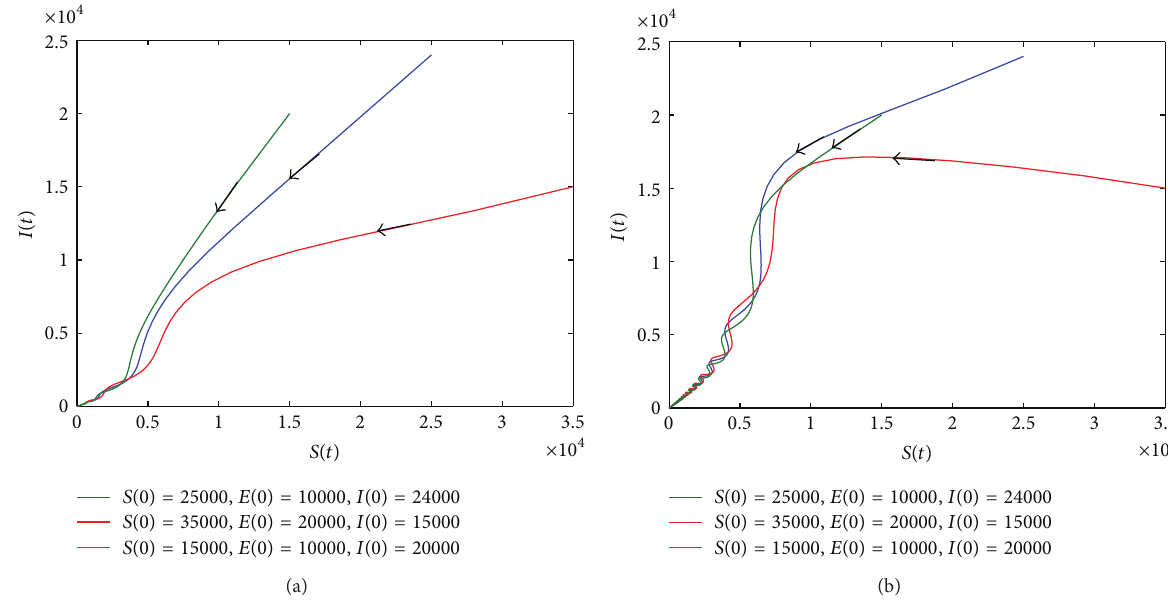
Figure 4: Phase plane of 𝑆(𝑡) and 𝐼(𝑡) . (a) When the parameter values are 𝑟 = 0.11 , 𝑎 = 0.9 , 𝑏 = 0.2 and 𝜇 = 0.3 , 𝑅 0 = 1.4991 , 𝑅 𝑑 = 1.1 > 1 , < 𝑅 𝑢 = 1.4159 , and 𝑅 < 𝑅 𝑙 = 1.2773 . (b) When the parameter values are 𝑟 = 0.126 , 𝑎 = 0.7 , 𝑏 = 0.2 , and 𝜇 = 0.3 , 𝑅 𝑅 𝑑 𝑑 1 1